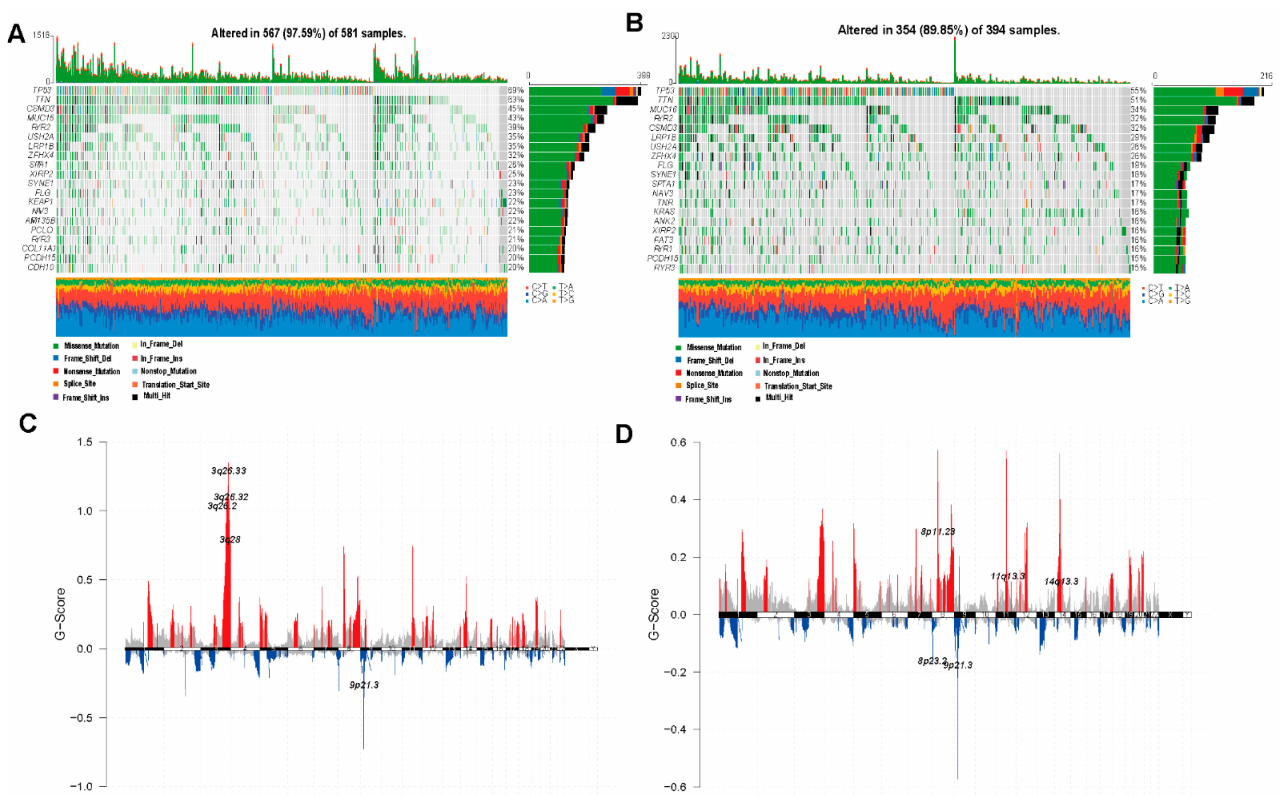
Figure 8. Analysis of molecular characteristics of high and low ferroptosis groups in the TCGA dataset. ( A , B ) The distribution of gene mutations in the samples of high ( A ) and low ( B ) ferroptosis score groups. ( C , D ) Distribution of copy number amplification and deletion regions in the samples of high ( C ) and low ( D ) ferroptosis score